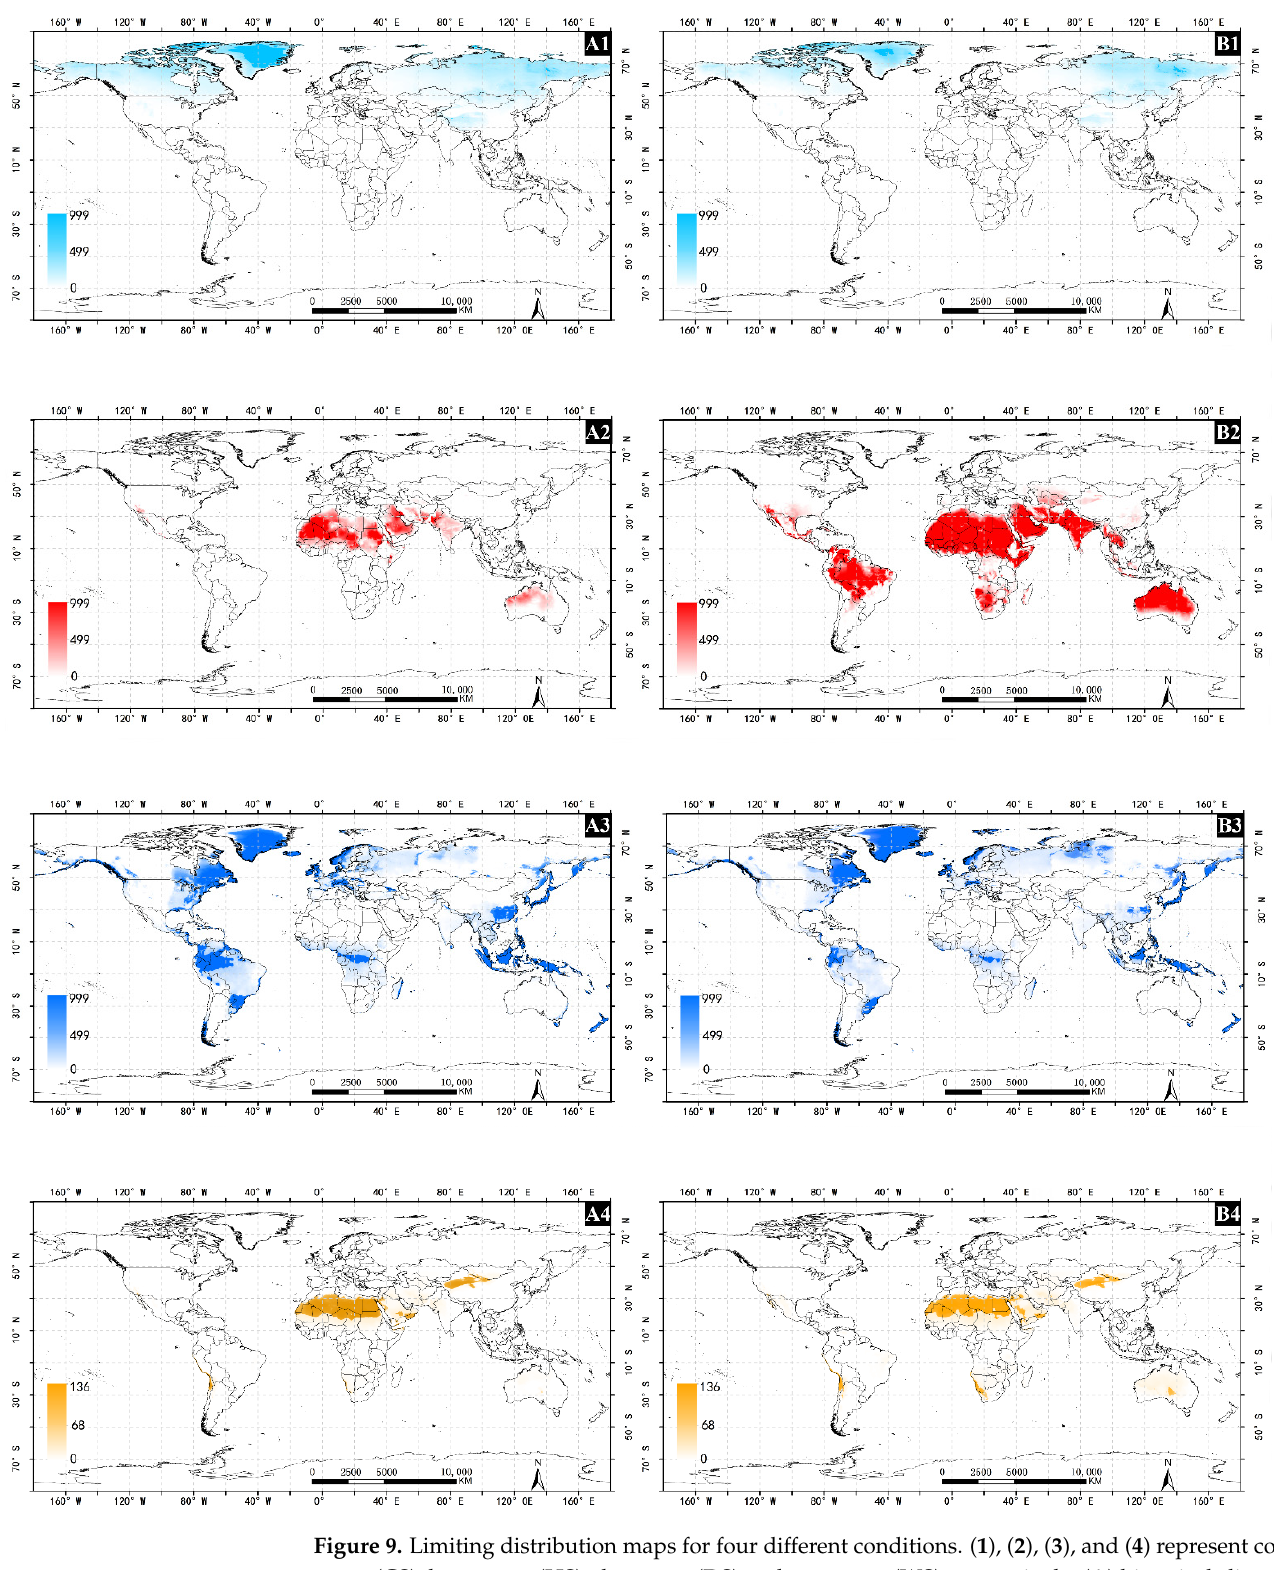
Figure 9. Limiting distribution maps for four different conditions. ( 1 ), ( 2 ), ( 3 ), and ( 4 ) represent cold stress (CS), heat stress (HS), dry stress (DS) and wet stress (WS), respectively. ( A ) historical climatic conditions; ( B ) future climatic conditions.